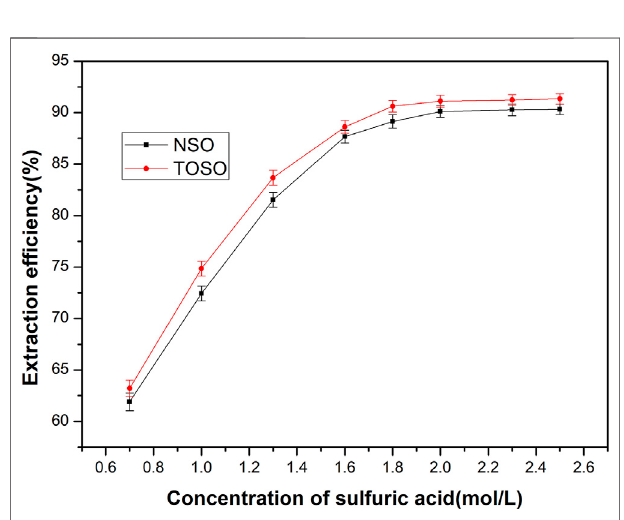
FIGURE 2 | In fl uence of H 2 SO 4 on Cu 2+ stripping ef fi ciency.